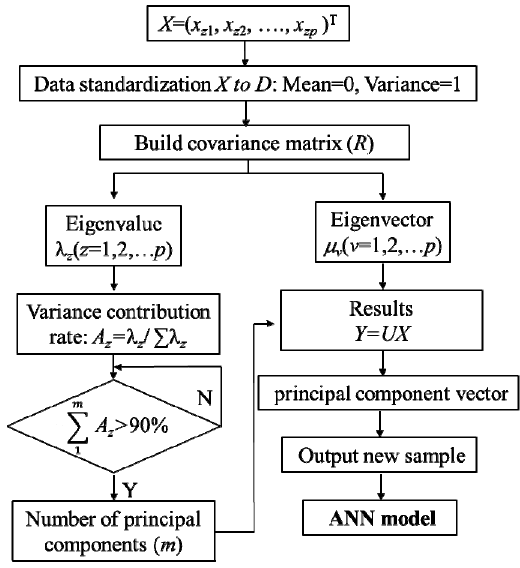
Figure 2. Flow chart of PCA.